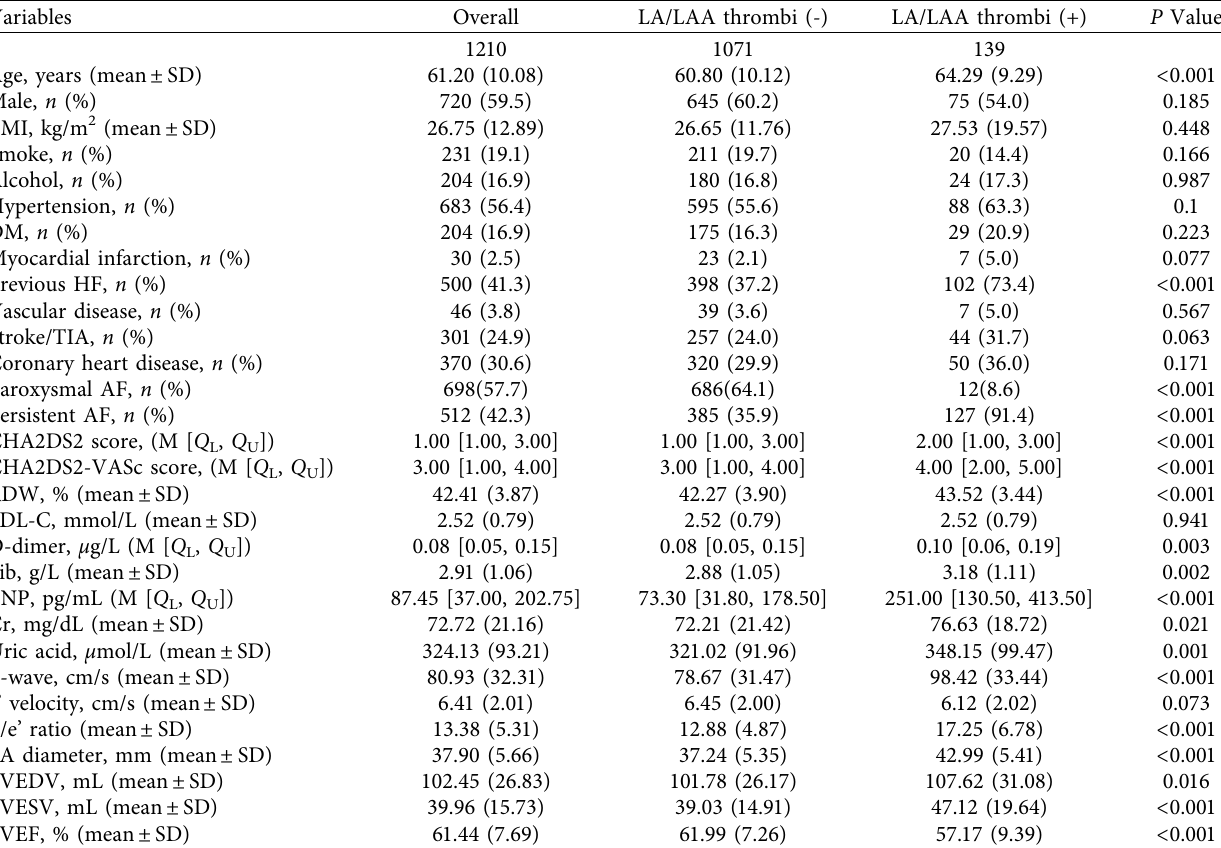
Table 1: Comparison of the baseline condition between non-LA/LAA thrombi and LA/LAA thrombi group. Variables